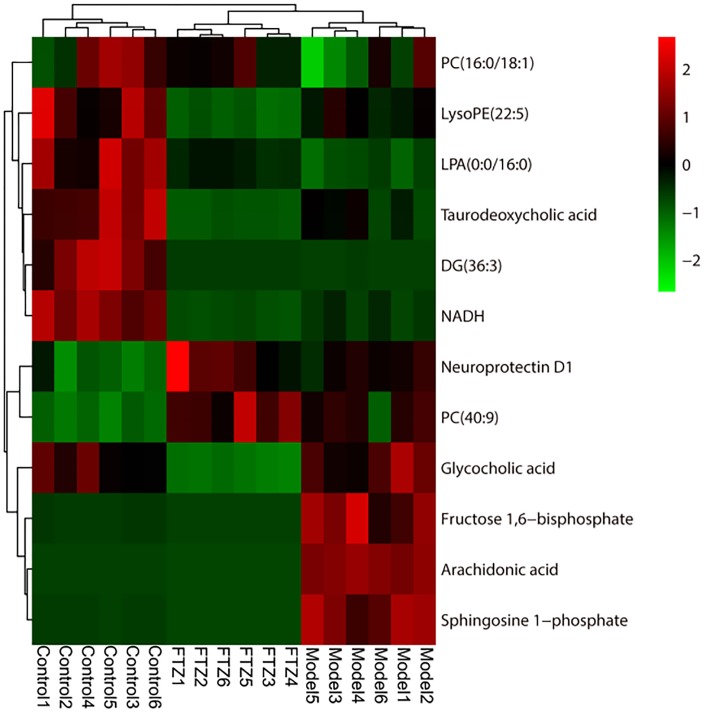
Heatmap of 12 potential biomarkers among control, model, and FTZ groups. Red and green indicate increased and decreased levels, respectively.